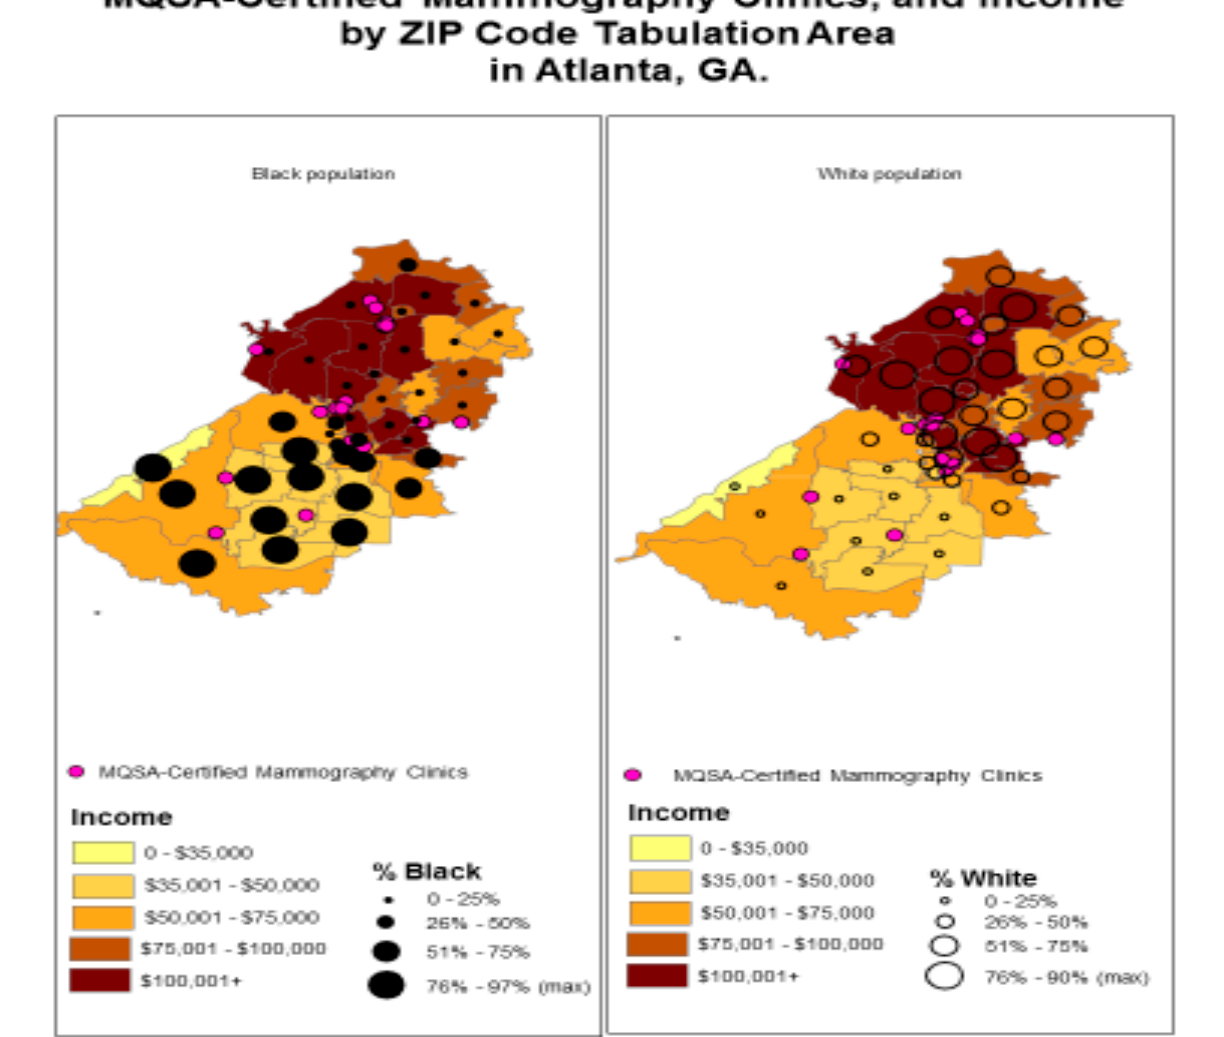
Figure A2. Percent White vs. Percent Black Population, MQSA-Certified Mammography Clinics, and Income by ZIP Code Tabulation Area in Atlanta, GA.